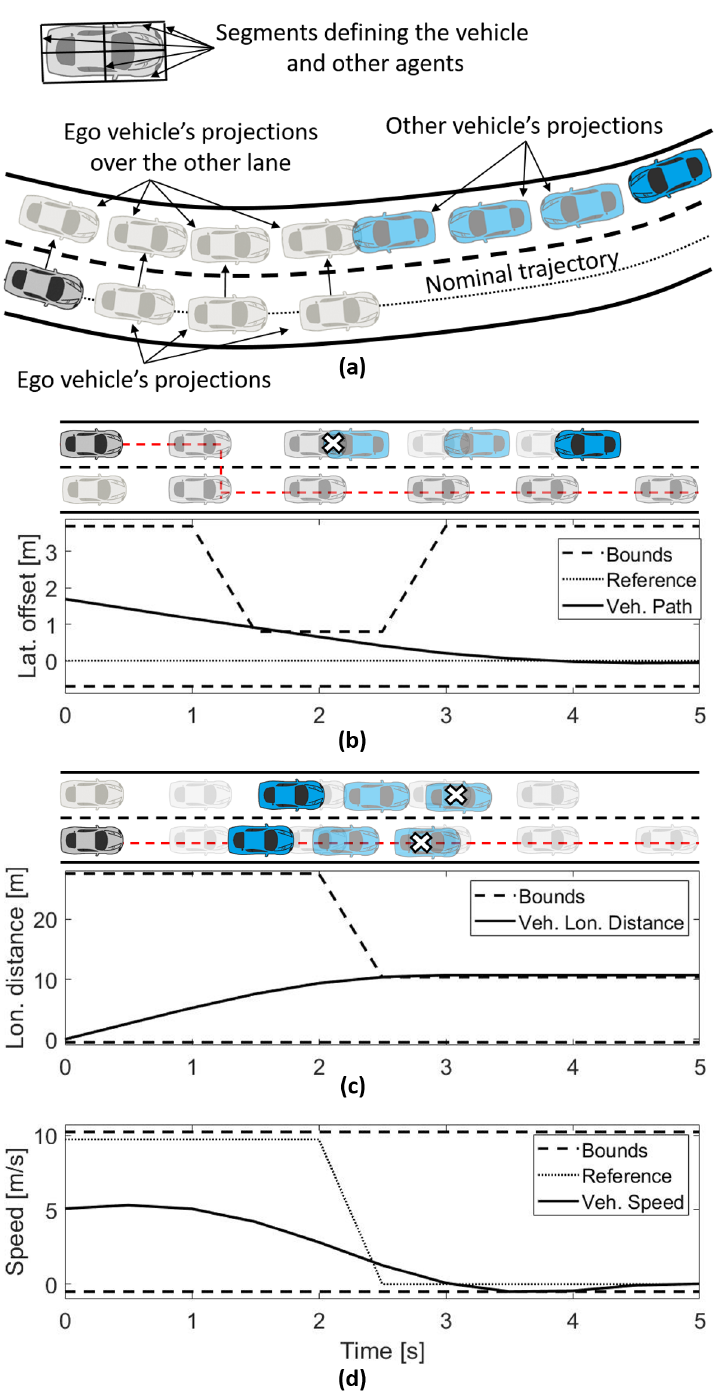
Figure 5. ( a ) Vehicle projections and segmentation. ( b ) Lateral offset reference and constraint manip- ulation. ( c ) Longitudinal position constraint manipulation. ( d ) Longitudinal speed reference and constraint